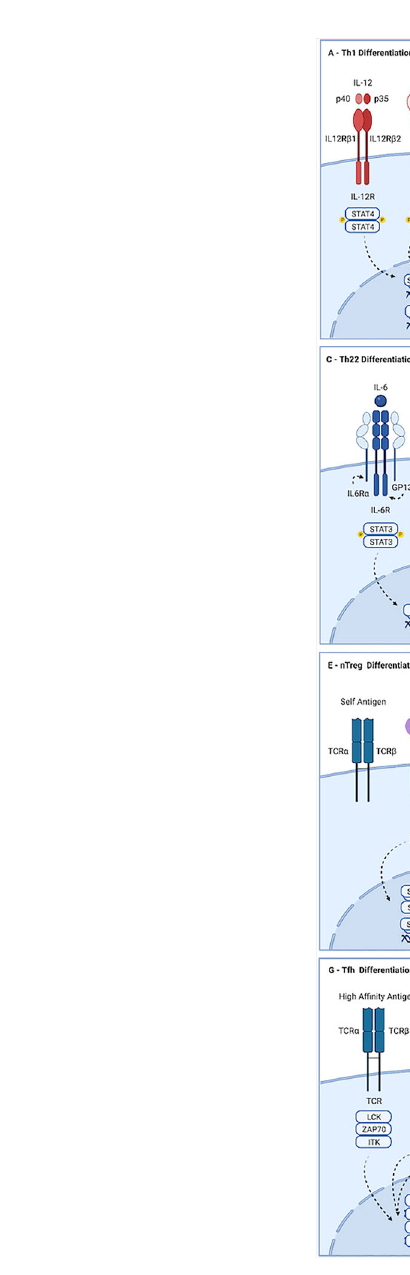
FIGURE 1 | Molecular determinants guiding CD4 + T cell differentiation. (A) Th1 development is initiated by IL-12 mediated STAT4 dimerization, driving expression of TBX21 . Activation of mTORC1, primarily by CD28, is also required. Maturation occurs in response to IL-12, and to STAT1 activation by autocrine IFN- g . (B) Th2 differentiation is driven by IL-4, which promotes STAT6-dependent transcription of GATA3, and by mTORC2. (C) Th22 cells form in response to IL-6 driven STAT3 activation, leading to production of AHR . The contributions of mTORC1 and mTORC2 to this process remain unclear. (D) IL-6 in the presence of TGF-b-mediated SMAD activation and strong activation of mTORC1 drives transcription of ROR-yt , which primes cells to acquire a Th17 fate. Maturation occurs downstream of IL-23 mediated STAT3 activation. IL-23 and IL-1b can also promote STAT4-mediated induction of TBX21 in Th17 cells, leading to production of IFN- g and GM-CSF. (E, F) nTreg cells develop in the thymus following exposure to self-antigen. pTreg cells develop in the periphery in response to foreign antigen. Both require TGF- b and IL-2 to activate SMAD and STAT5 signaling, respectively, which drive transcription of FOXP3 . While strong activation of AKT and mTOR favors effector cell development, weak induction favors regulatory cells. (G) Strong TCR stimulation and ICOS ligation by dendritic cells promotes Tfh differentiation. ICOS activates AKT, but also drives STAT3-mediated production of TCF1 , which promotes expression of BCL6 . Maturation requires continued TCR and ICOS stimulation by B cells. Recently activated cells fated to become Tfh produce IL-2. Signaling is largely paracrine, and drives STAT5 mediated induction of BLIMP1 , a mutual antagonist of BCL6, in non- Tfh. (H) Events guiding Tfr differentiation overlap substantially with those of Tfh. Tfr are thought to be derived from FOXP3-positive precursors. As with Tfh, ICOS- mediated STAT3-dependent induction of TCF1 promotes BCL6 expression. However, Tfr appear to depend exclusively on mTORC1, whereas Tfh require both mTORC1 and mTORC2. Similarly, induction of CXCR5 in Tfr appears to require NFAT2, which is dispensable for Tfh development. Created with